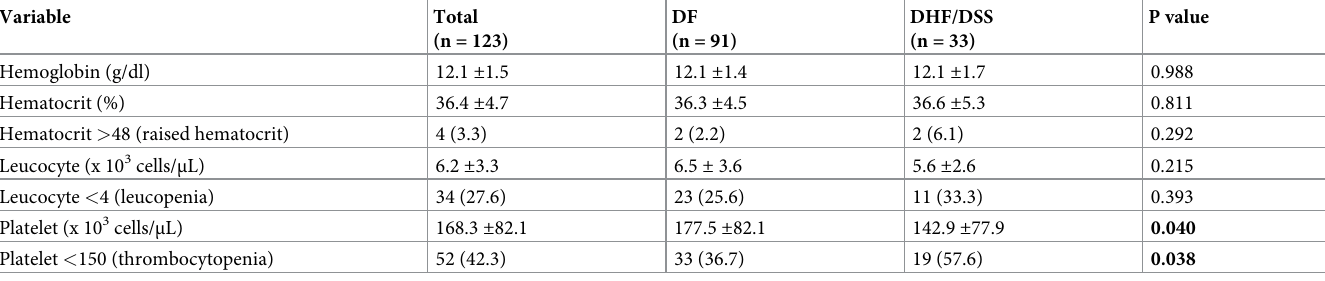
Table 3. Hematological profile of children with dengue at